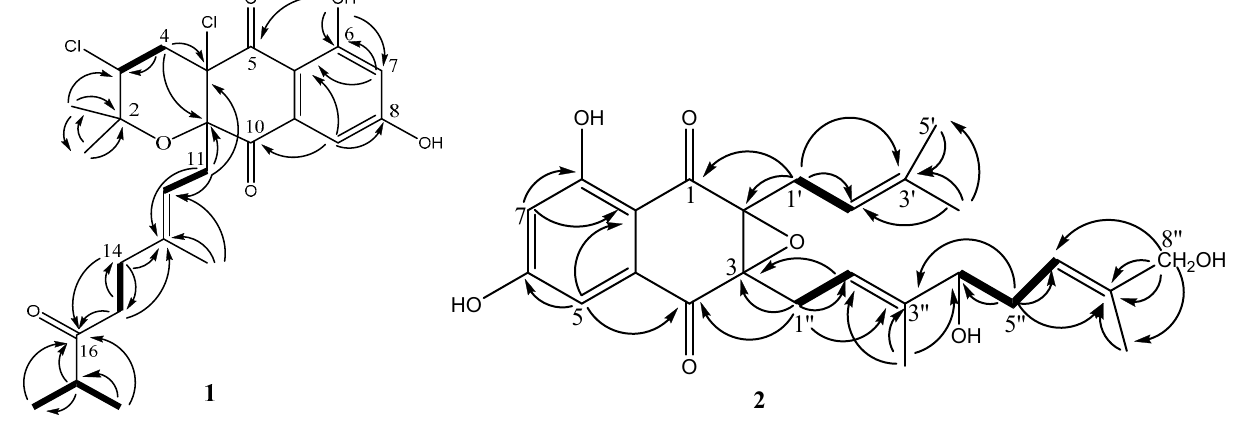
Figure 4. 1 H– 1 H COSY (bold lines) and HMBC (arrows) correlations of compounds 1 and 2 .